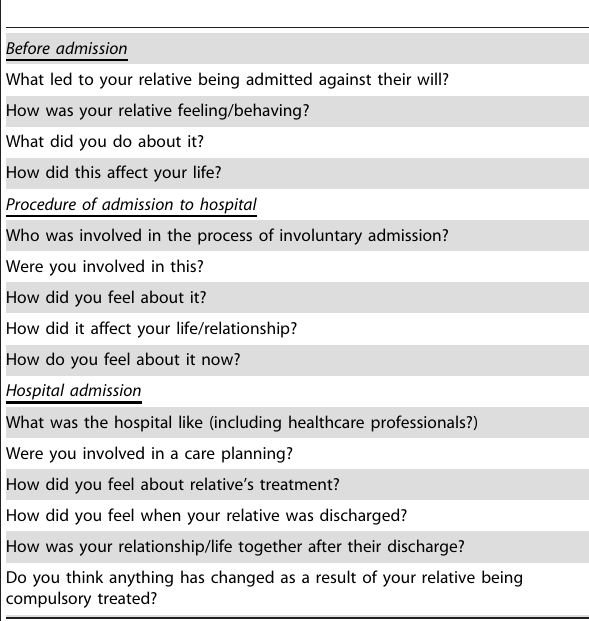
Table 1. Main topics for qualitative